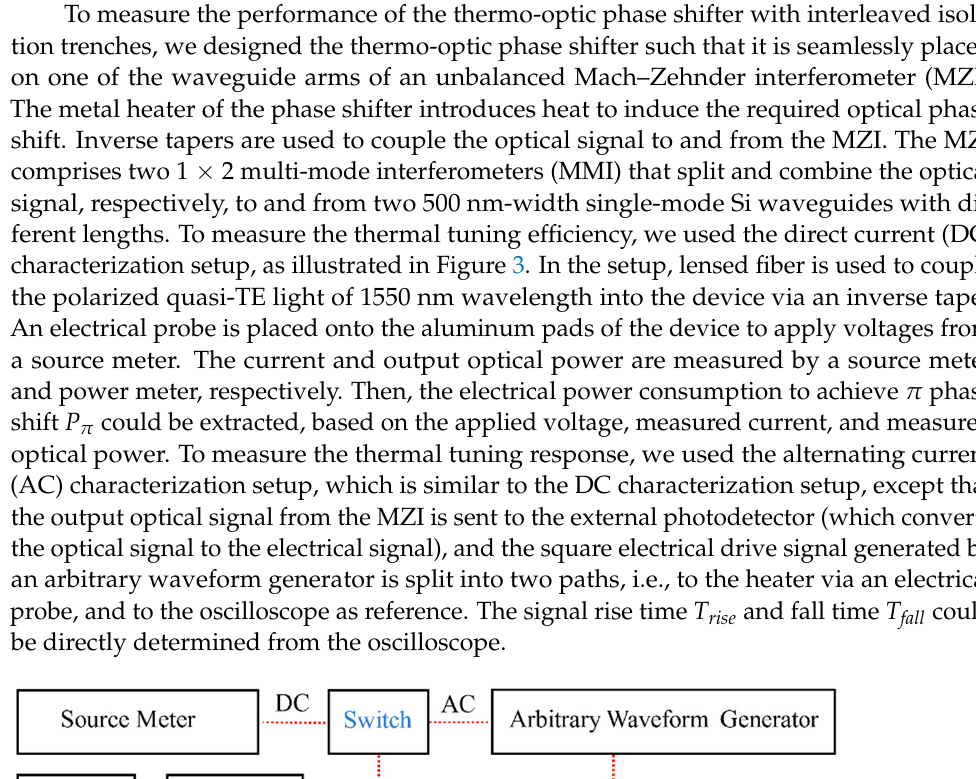
Figure 2. Top-view optical microscopy image of the fabricated thermo-optic phase shifters with interleaved isolation trenches with different duty ratios.